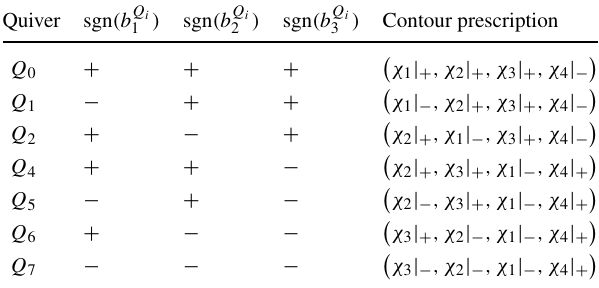
Table 3 For each quiver Q i in Fig. 8, we list the signs of the β -function coefficients b Q i for the three 2d nodes, which are also the signs of the I . These signs determine whether the corresponding FI parameters ζ Q i I integration contour for the corresponding χ -variable has to be closed in the upper ( + ) or lower ( − ) half-plane. The last column displays the contour prescription from which we can also read which χ -variable is associated to which node of the quiver. The variable χ 4 is always the last one to be